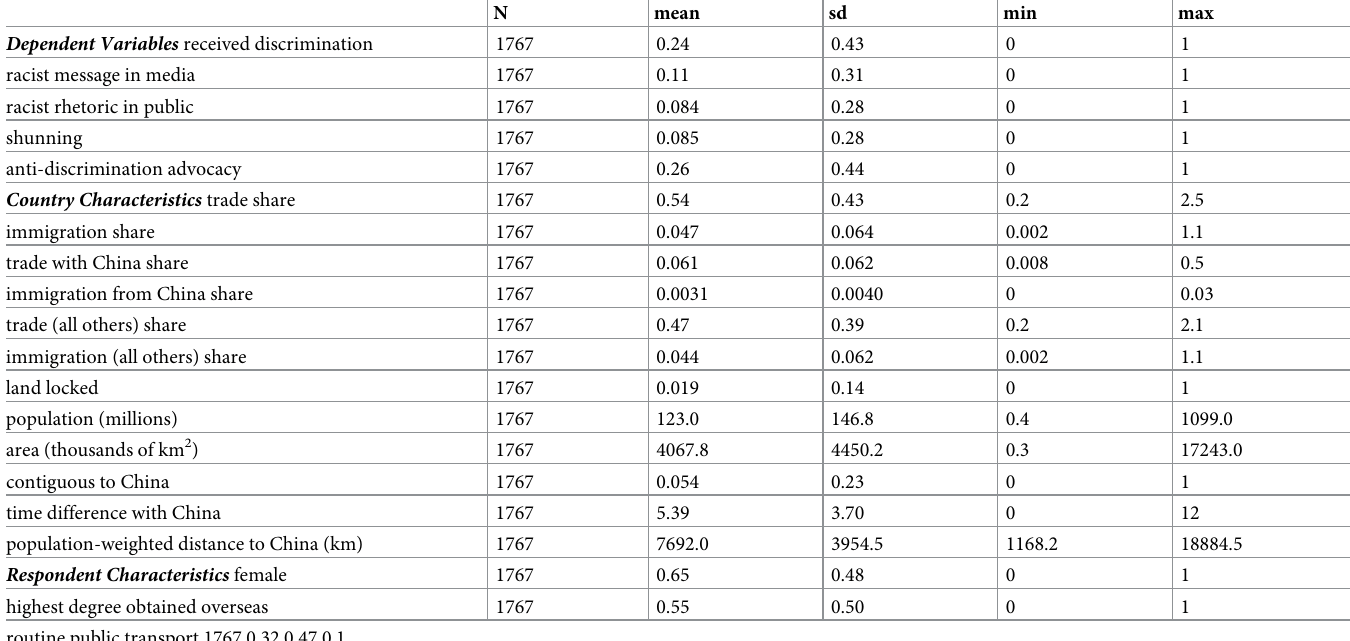
Table 1. Descriptive